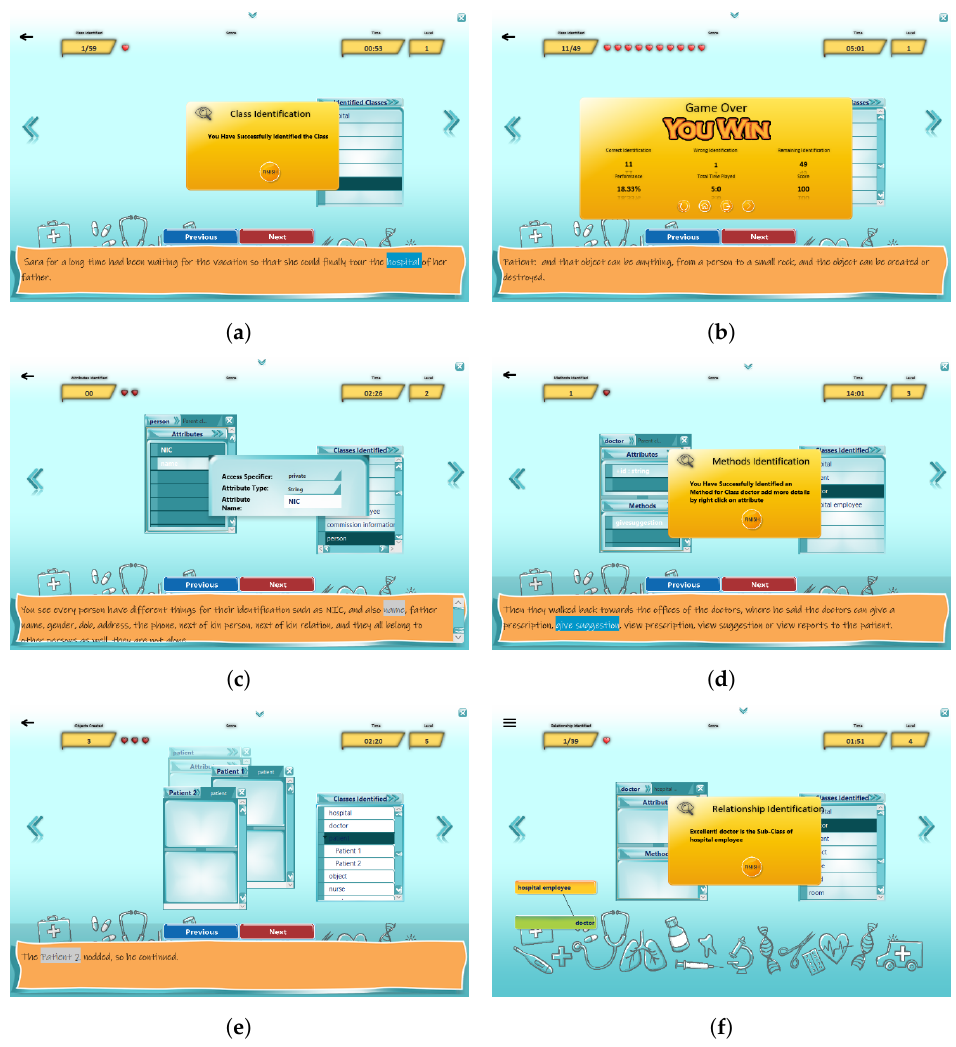
Figure 4. Game levels include: ( a ) Level-1—learning about the class identification. Taken from [38]. ( b ) Statistics/evaluation of the Level-1. ( c ) Level-2—learning about the attributes of the identified class. ( d ) Level-3—learning about the methods of the identified class. ( e ) Level-4—learning about the objection creation. ( f ) Level-5—learning about the relationship between